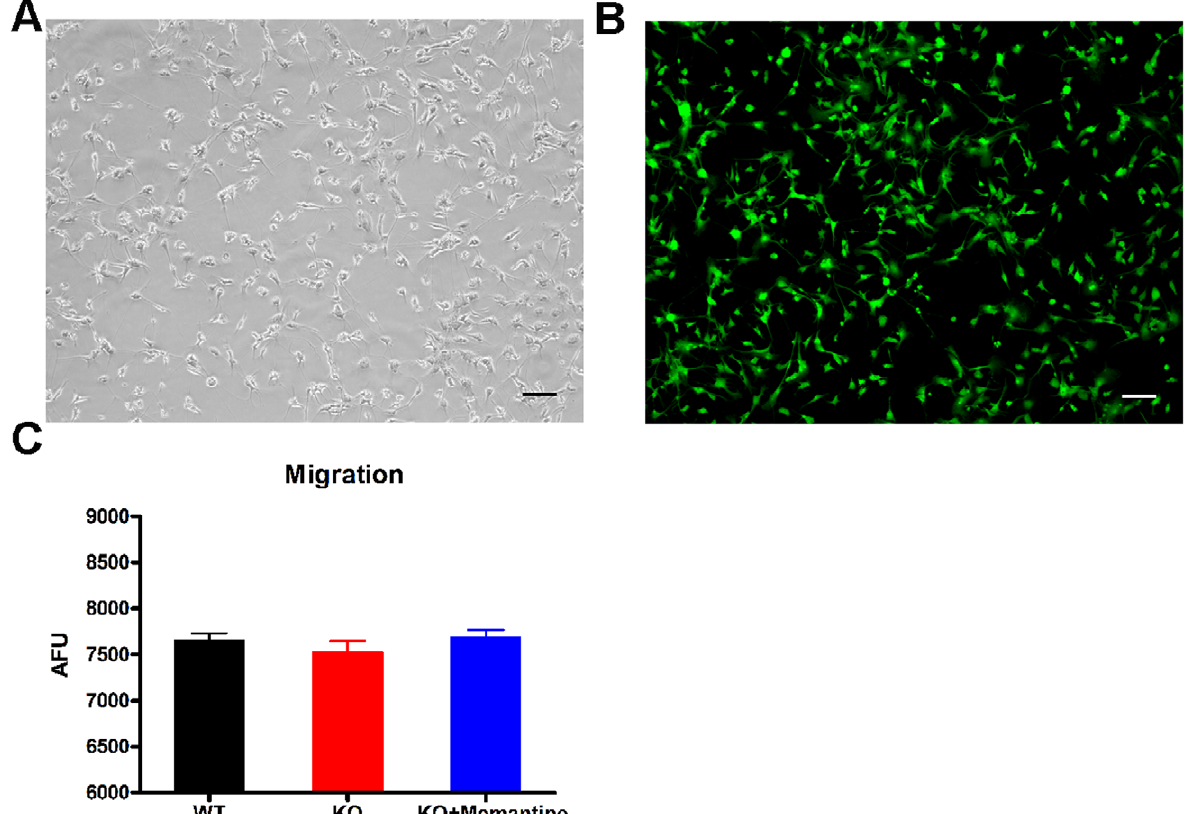
Figure 3. Memantine had little effect on CGCs migration. A. Cultured CGCs. Scale bar, 100 m m. B. CGCs stained with Calcein AM dye in modified Boyden chamber migration assay. Scale bar, 100 m m. C. Comparison of CGCs migration. The values are mean 6 SE from three independent experiments with five replicates in each experiment. AFU: arbitrary fluorescence units.